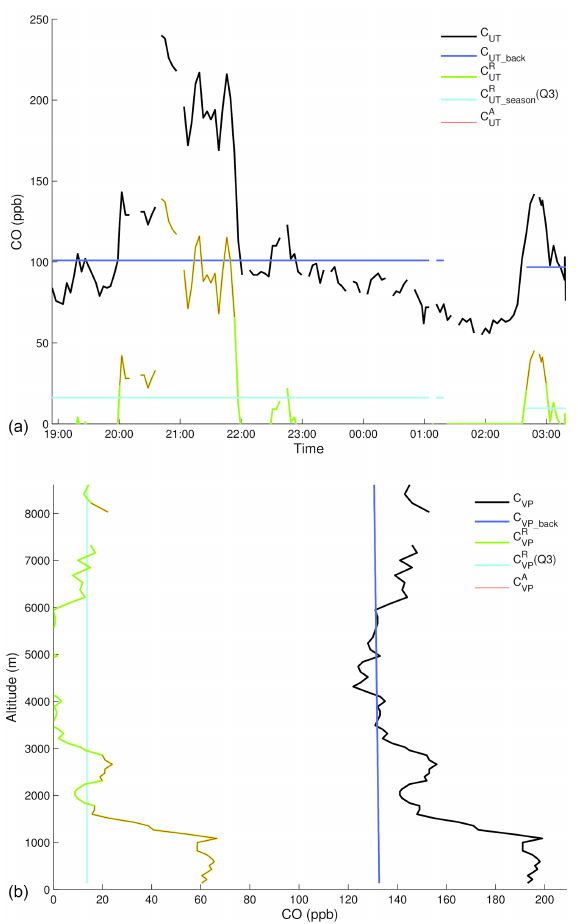
Figure 3. Methodology used to extract CO anomalies along the flight track for (a) the cruise part of the flight and (b) during takeoff and landing. Further details are given in Sect.